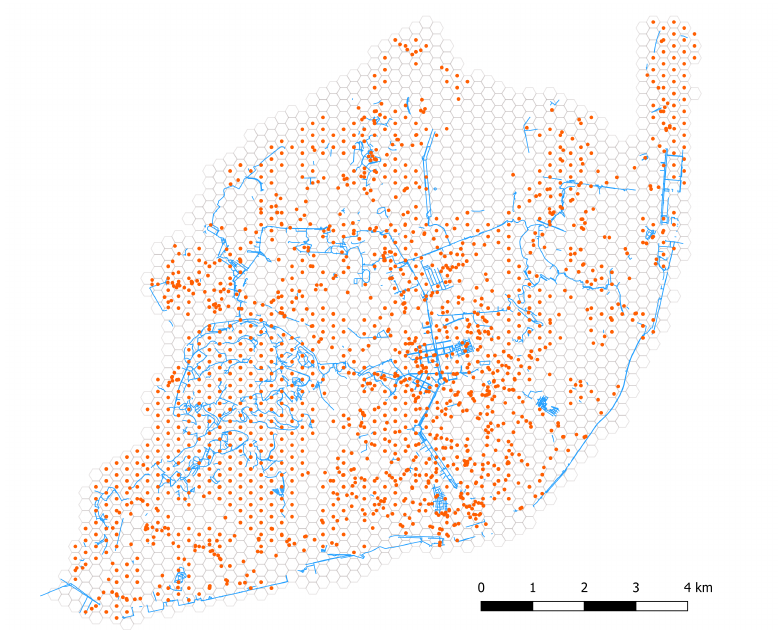
Figure A1. Destinations, hexagonal grid, and low stress